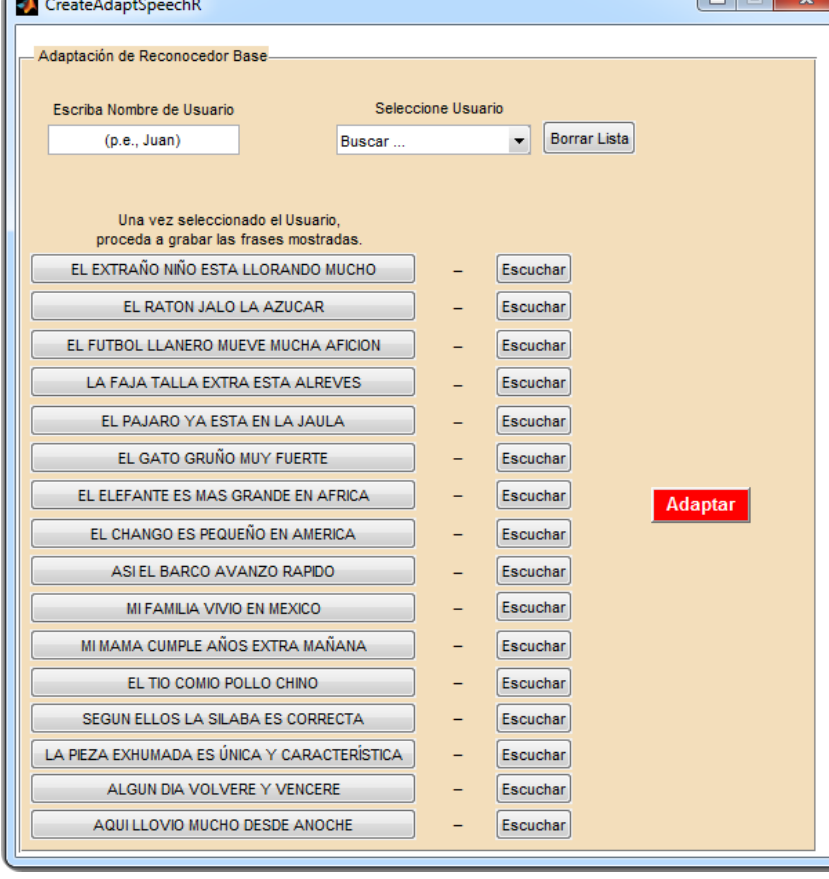
Figure 4. Speech adaptation interface of the speech-to-text